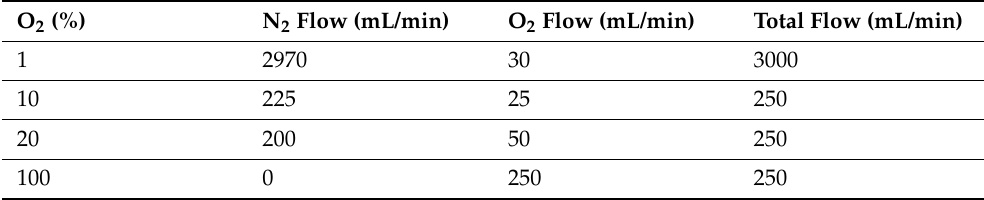
Table 1. Flows rates of oxygen and nitrogen for the different annealing. O 2 (%) N 2 Flow